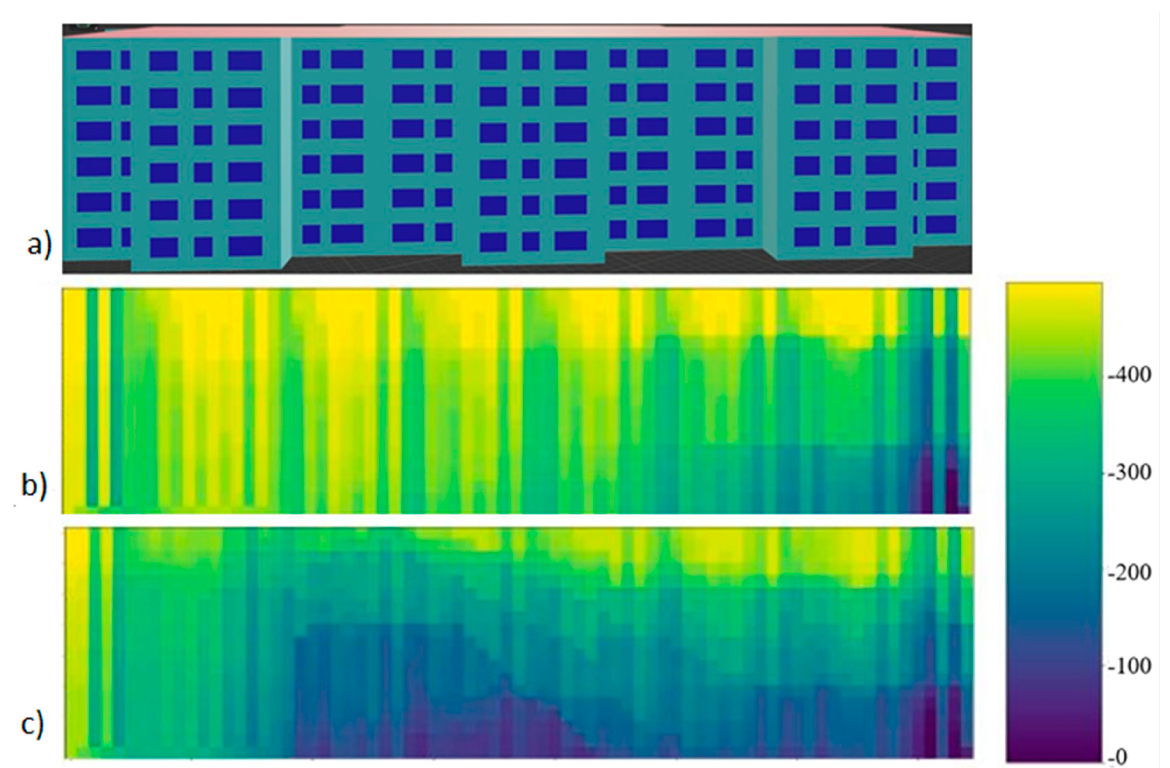
Figure 18. ( a ) Façade of one building in the Lorensborg–Bellevue 3CIM test area in Malmö; ( b ) raster representation of how much solar irradiance (kWh) the façade in ( a ) receives per year before the planned buildings are added; and ( c ) raster representation of how much solar irradiance (kWh) the façade in ( a ) receives per year after the planned buildings are added.